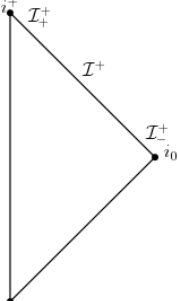
Figure 1 . Penrose diagram of 4d (cid:13)at space. I + denote the past and future boundaries of the null (cid:6) in(cid:12)nity I + . These boundaries are essentially future time like in(cid:12)nity i + and the spatial in(cid:12)nity i 0 .